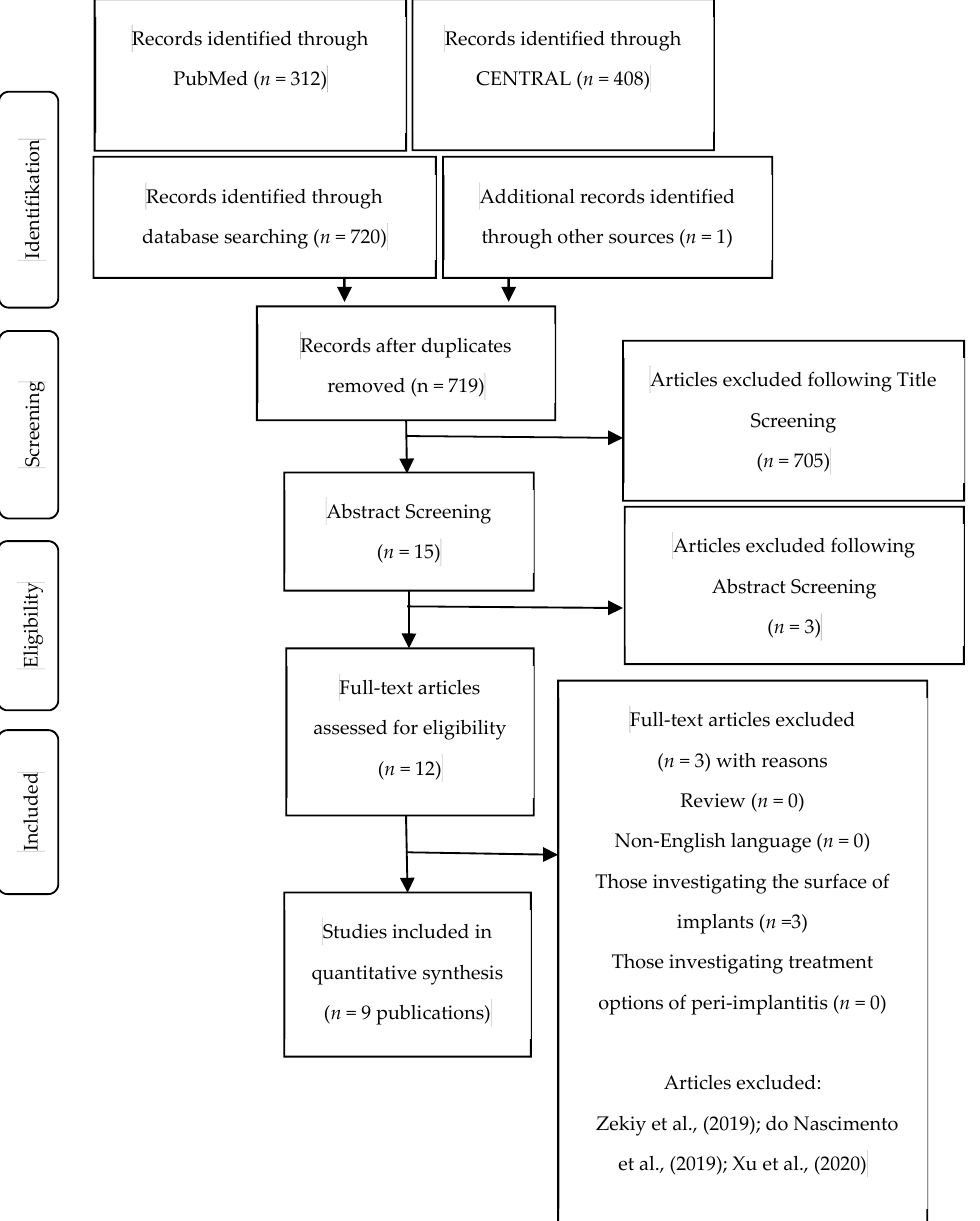
Figure 1. Data extraction process and study selection.